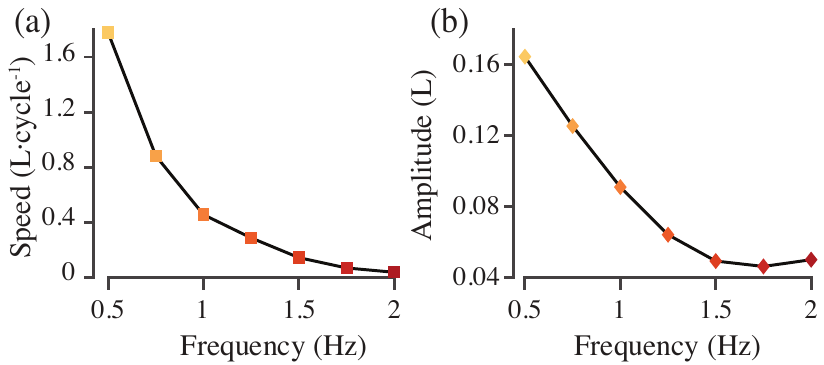
Figure 7. Swimming speed ( a ) and tail beat amplitude ( b ) as a function of actuation